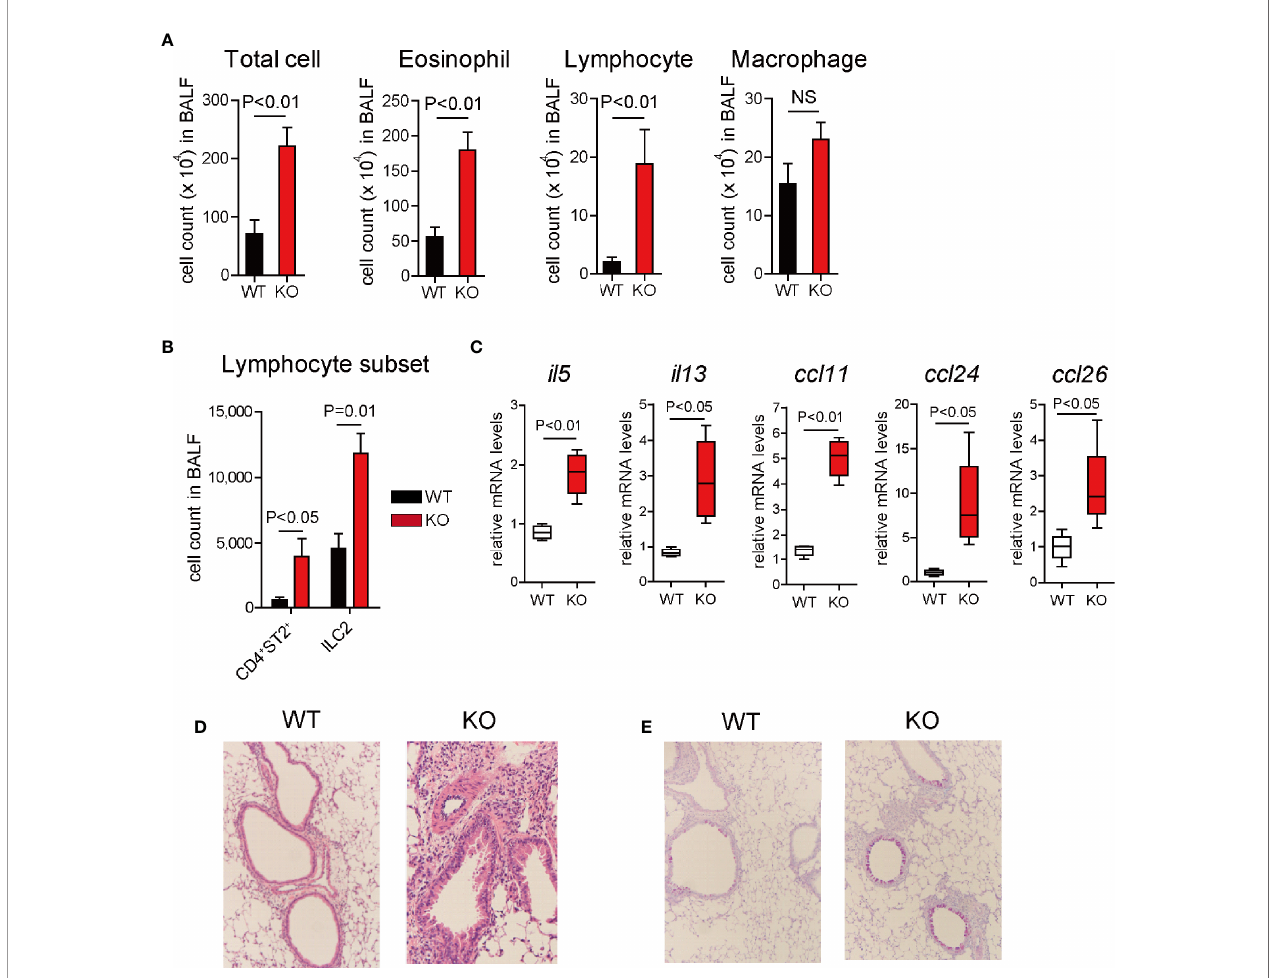
FIGURE 1 | 12/15-lipoxygenase de fi ciency augments IL-33-induced airway eosinophilic in fl ammation. Airway in fl ammation was induced by administration of IL-33 (500 ng per mouse, intranasal), for 3 consecutive days, in C57BL/6 and 12/15-lipoxygenase de fi cient mice. Analysis was performed 4 days after the fi nal administration of IL-33. (A) Number of total cells, eosinophils, lymphocytes, and macrophages in BALF. (B) Number of ILC2 and Th2 cells in BALF by fl ow cytometric analysis. (C) Relative mRNA expression of cytokines ( il5 , il13 , ccl11 , ccl24 , and ccl26 ) was determined by RT-PCR and quantitative real-time PCR analysis. Airway histology was assessed by (D) hematoxylin and eosin and (E) periodic acid – Schiff (PAS)-Alcan blue staining. The data are representative of three independent experiments. Mean ± SEM, n=4 for each